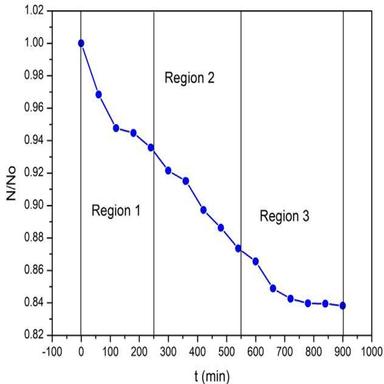
Variation in gas moles during formation of hydrates in sediments at 17.2 MPa.